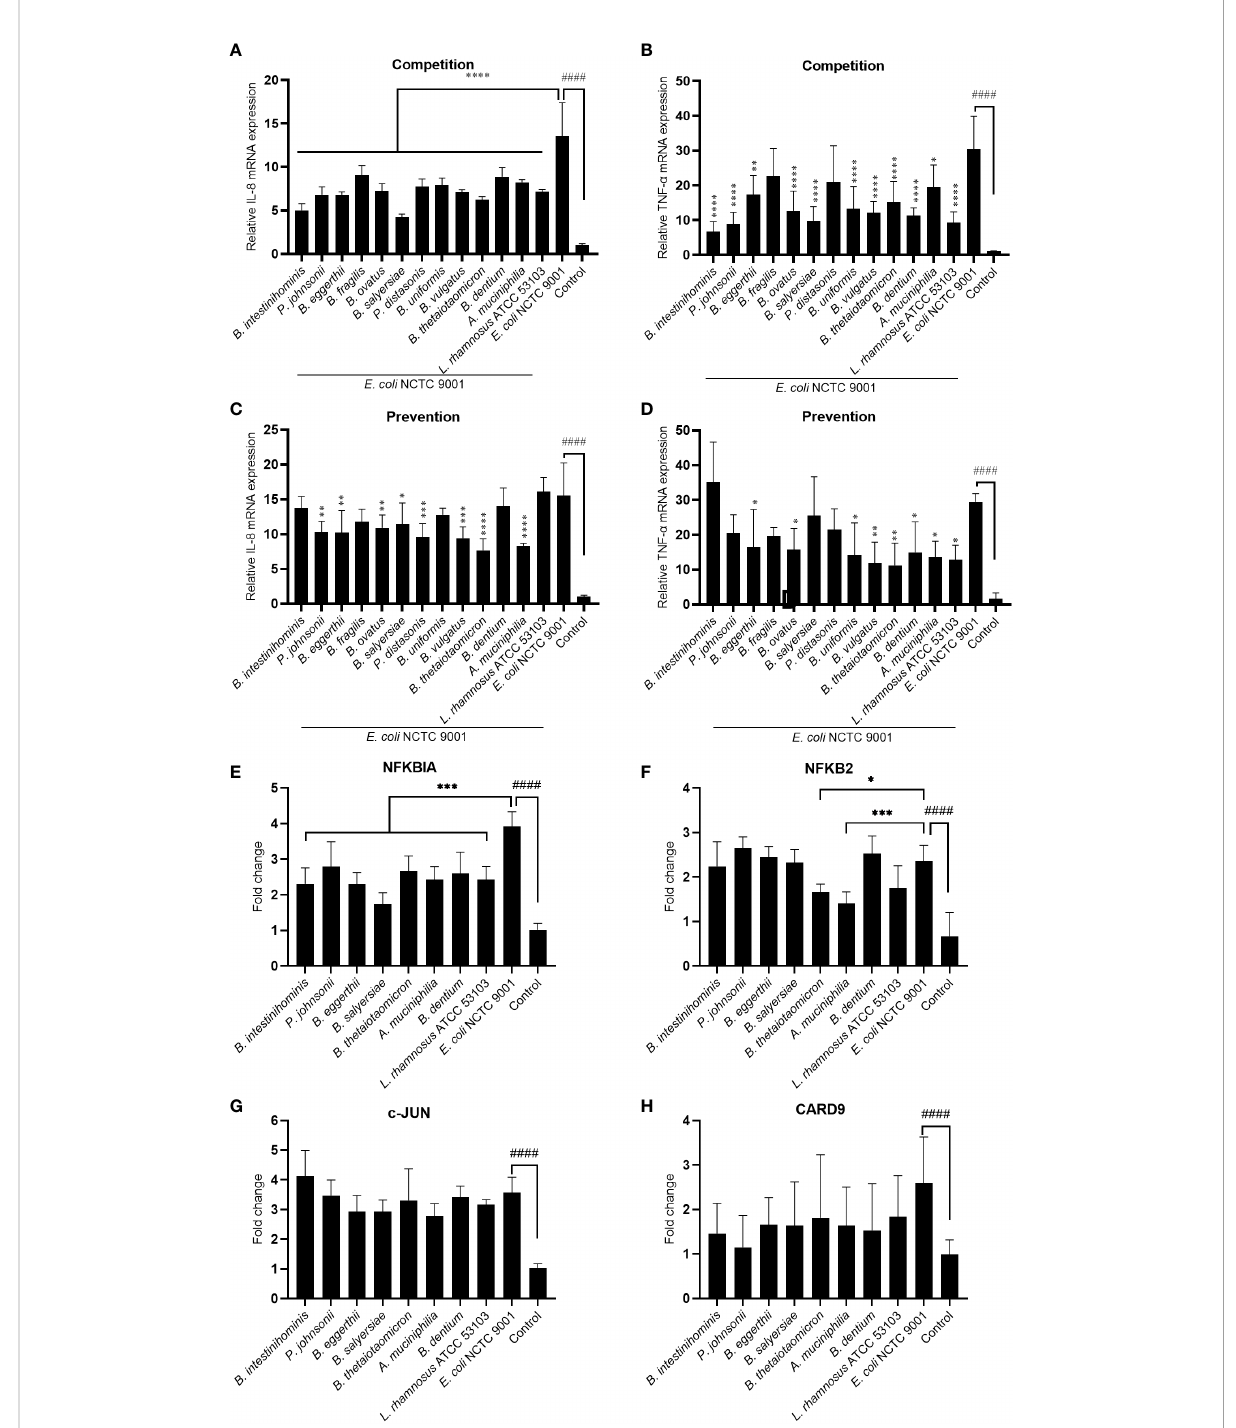
FIGURE 3 Mucin-degrading gut commensals alleviate the pathogenic E. coli induced in fl ammation by downregulating the NF-kB signaling pathway. HT-29 cells co-incubated (competition) or pre-incubated (prevention) with gut commensals were challenged by E. coli 2 h. The IL-8 (A, C) and TNF- a (B, D) mRNA expression in HT-29 cells was detected by qPCR. HT-29 cells incubated with gut commensals were challenged by E. coli NCTC9001 for 2 h, mRNA expression of NF-kB and MAPK pathway involved gene NFKBIA (E) , NFKB2 (F) , c-Jun (G) and CARD 9 (H) were measured by qPCR. All data are presented as the mean ± SD of three biological replicates with two technical replicates. ####p < 0.0001 compared to the control group; *p < 0.05, **p < 0.01, ***p < 0.001, ****p < 0.0001 compared to the E. coli NCTC9001 group as determined by one-way ANOVA followed by Dunnett ’ s test for multiple